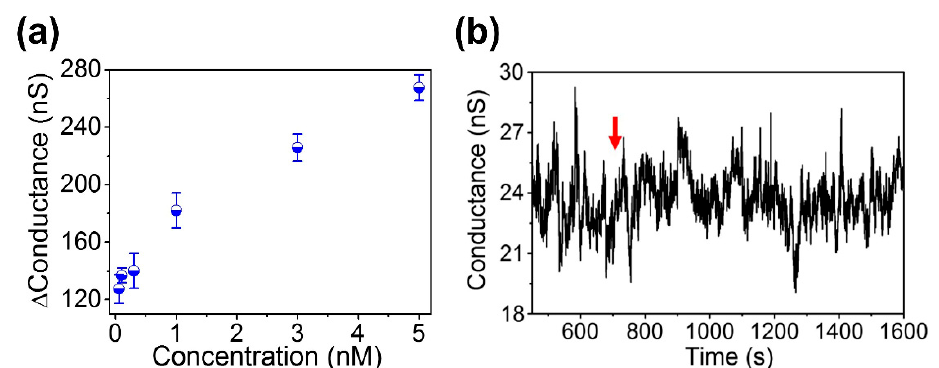
Figure 5. ( a ) Comparing electrical signals at six different concentrations of BoNT/E-Lc; ( b ) determination of selectivity in specific interactions using 3 nM BoNT/A-Lc. The red arrow in the figure indicates the injection of the target molecules.